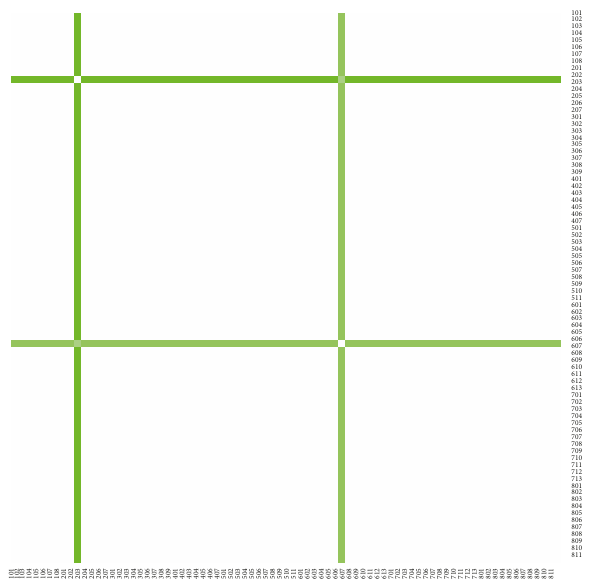
Figure 12: The distance matrix of the similarity of the districts for the male sex in